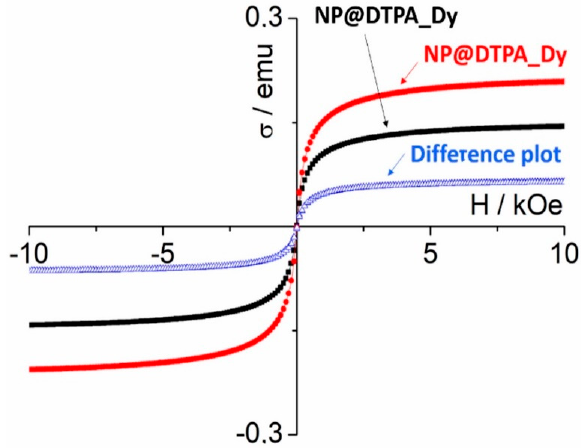
Figure 14. VSM measurements, at room temperature of NP@DTPA and NP@DTPA-Dy suspensions in water/glycerol mixture, showing the decrease of the magnetization promoted by the Dy 3+ ions, as evaluated by the difference plot (adapted with permission from [35]).